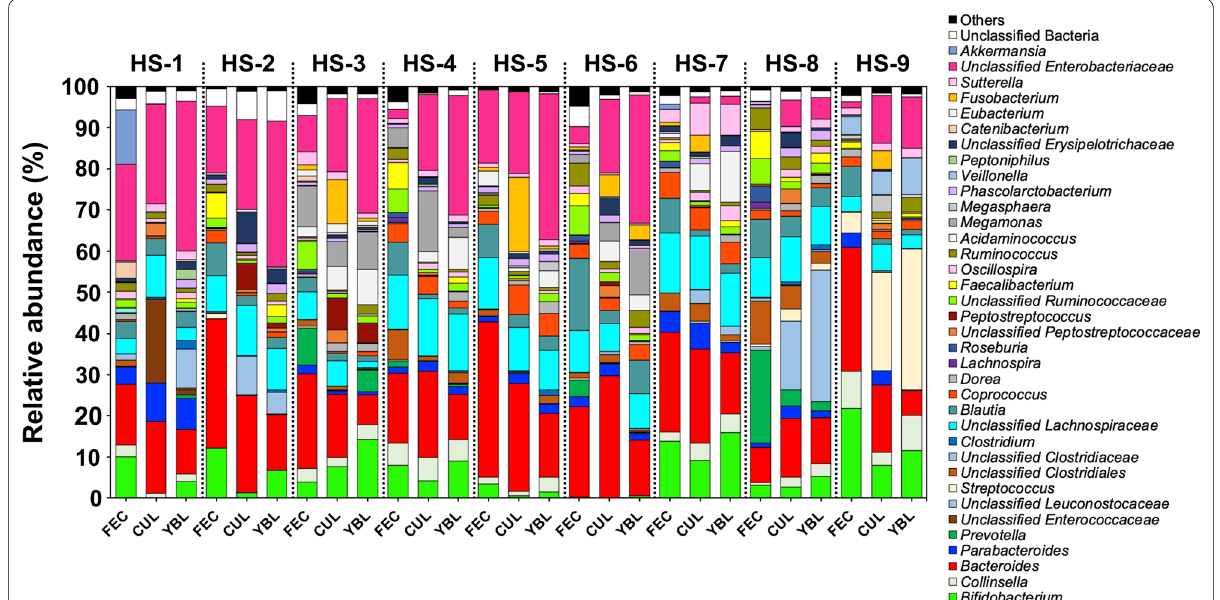
Fig. 3 Genus-level compositional views of bacteria. The compositional views of the original fecal samples (designated as FEC), KUHIMM cultures without 1.5% YBL (CUL), and KUHIMM cultures with 1.5% YBL (YBL) after 48 h of fermentation are shown. Fecal samples were obtained from nine healthy subjects (HS-1–HS-9) and each sample was used as the inoculum to construct the corresponding KUHIMM. Genera with low abundance (< 1.0%) and low similarity (< 97%) were included in the “Others” and “Unclassified bacteria” categories,